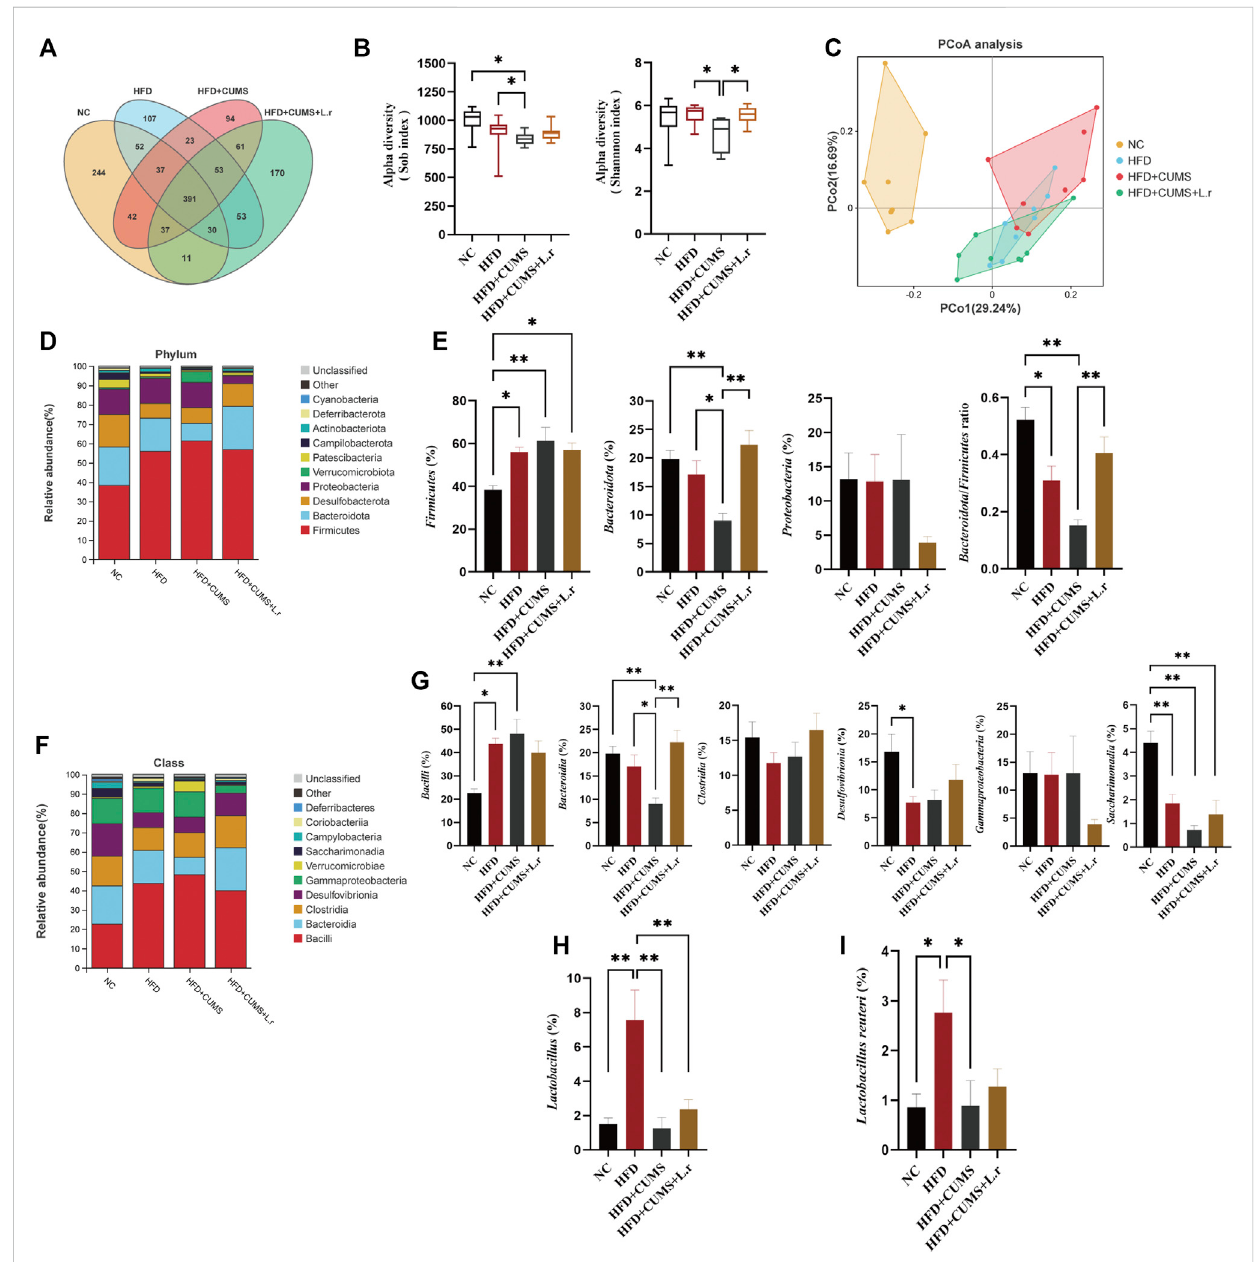
Gavagewith Lactobacillusreuteri reshapedthemicrobiomedysbiosis( n =8/group). (A) OTUVenndiagrambetween4groups. (B) SobandShannon indexes of the gut microbiota. (C) Weighted UniFrac PCoA analysis of the gut microbiota. (D) Phylum-level distribution of fecal microbiota. (E) Relative abundance of the phyla Firmicutes , Bacteroidetes , Proteobacteria and Bacteroidetes / Firmicutes ratio. (F) Class-level distribution of fecal microbiota. (G) Relative abundance of identi fi ed differential abundant bacterial groups at class level. (H) Relative abundance of Lactobacillus at genus level. (I) Relativeabundanceof Lactobacillusreuteri atspecieslevel.Dataareshownasthemean±SEM.* p < 0.05,** p < 0.01(Statisticalcomparisonsbetweenthe two groups were performed using the two independent samples t -test. Comparisons between multiple groups were performed using One-way ANOVA and Tukey